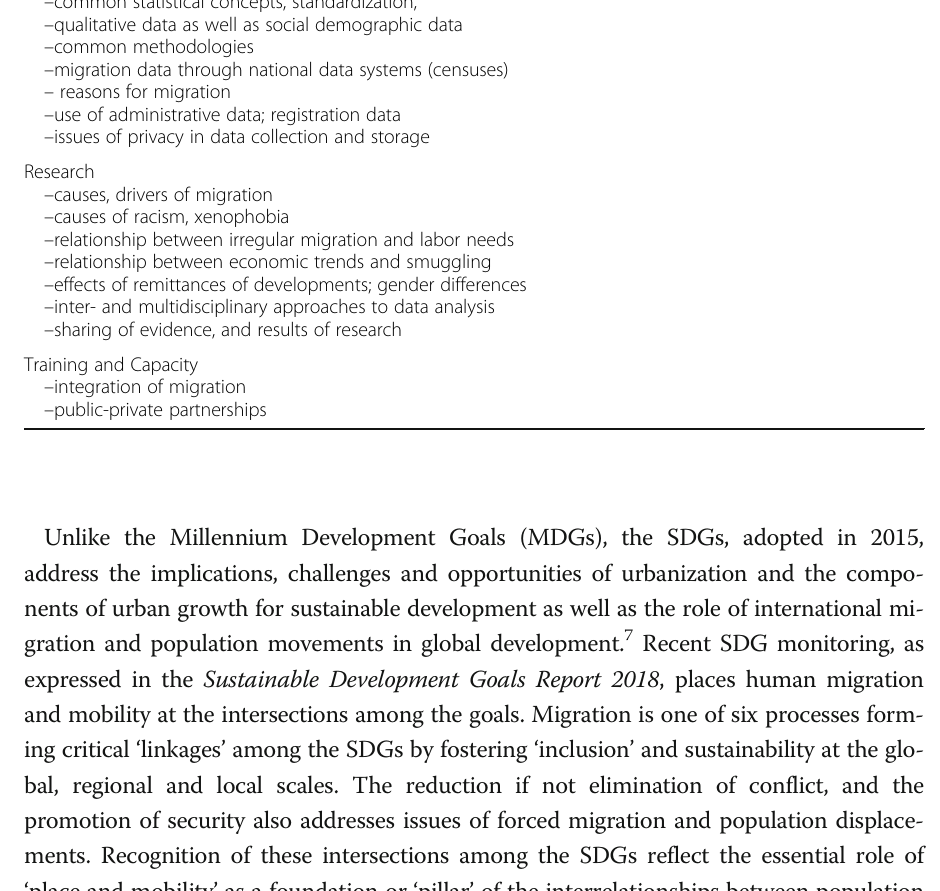
Table 3 Intersecting themes in demographic analysis of the Global Compact for Migration Data and Data Collection – disaggregation of data by age, gender, migration